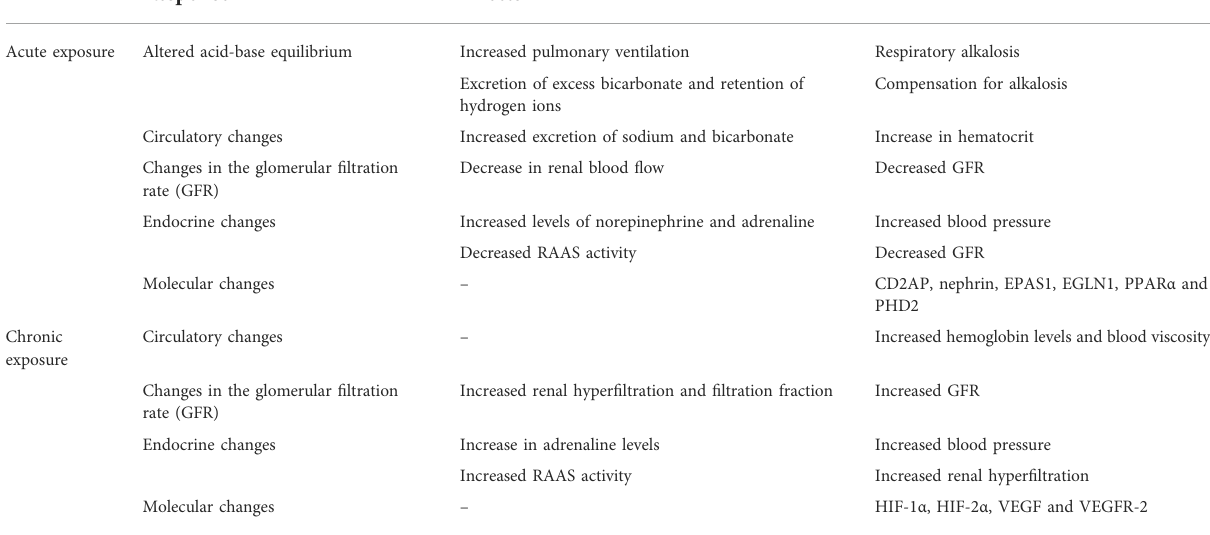
TABLE 1 Renal physiological response to acute and chronic high-altitude